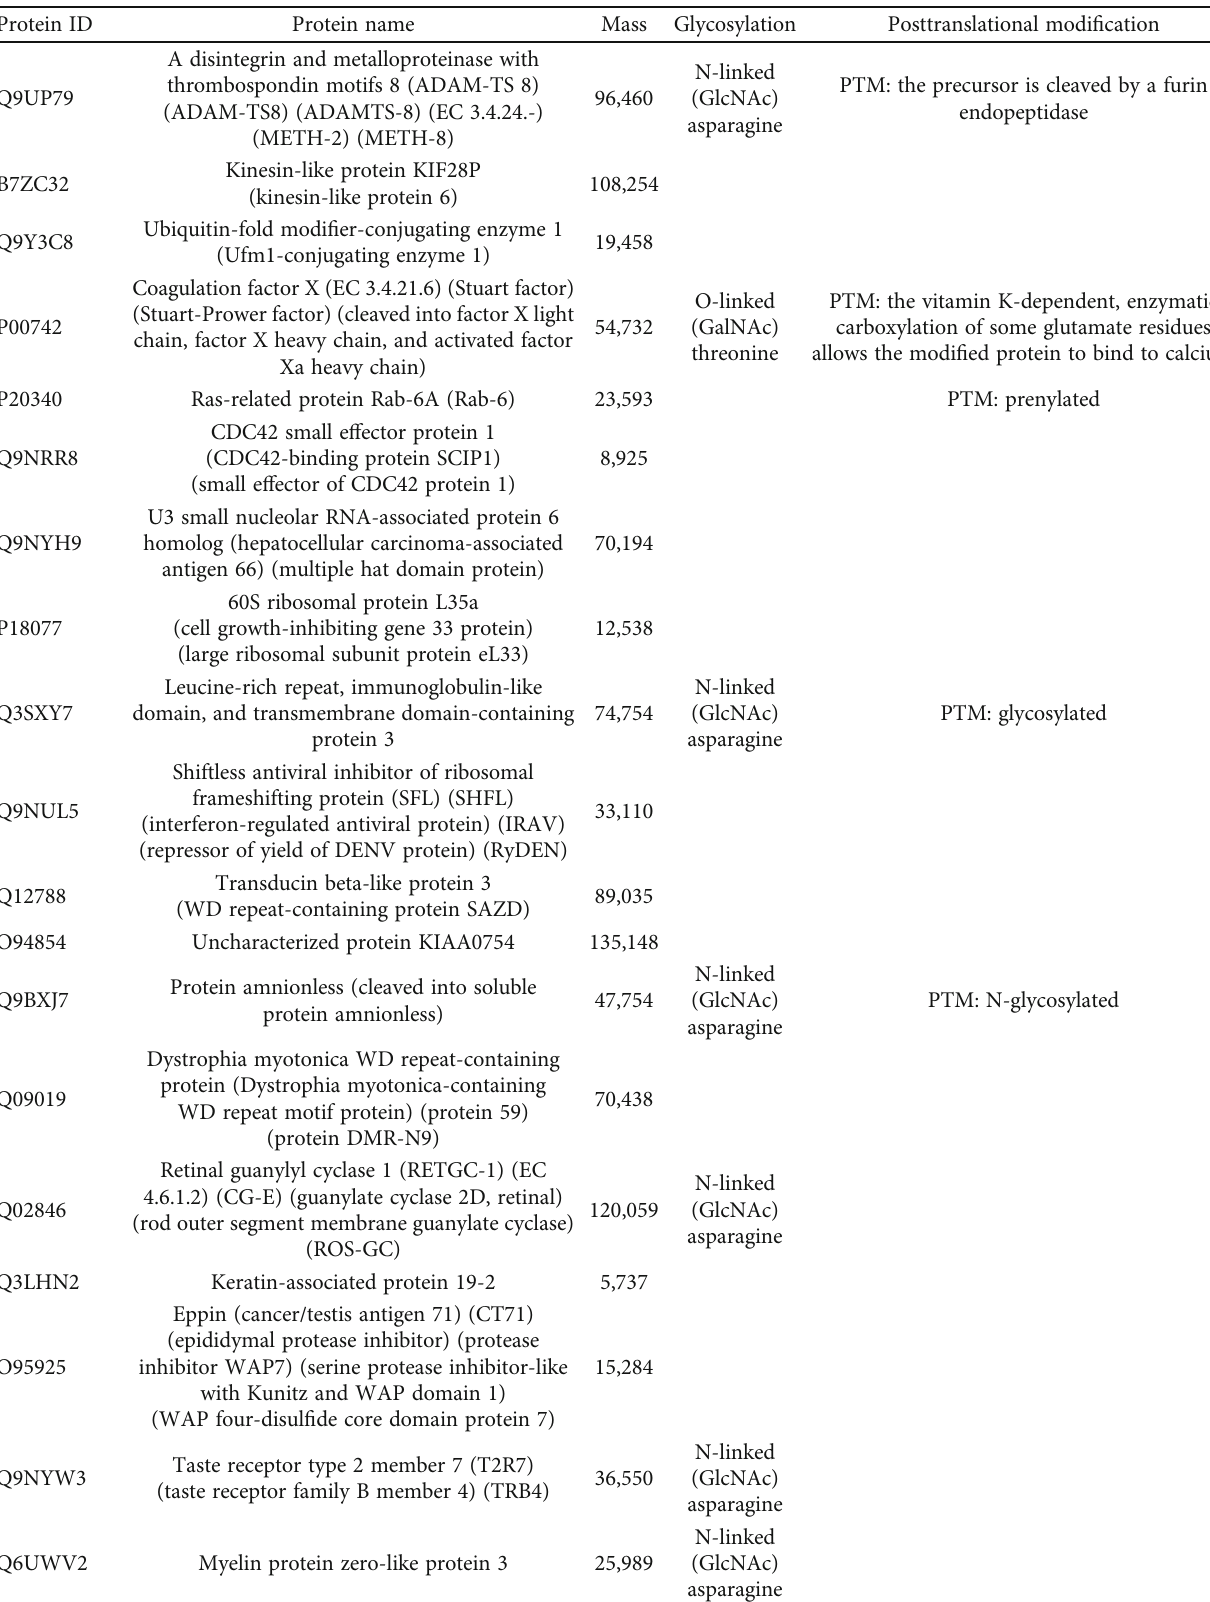
Table 3: Upregulated glycoproteins in the serum of the AD group (identi fi ed proteins from the UniProt Homo sapiens database). Protein